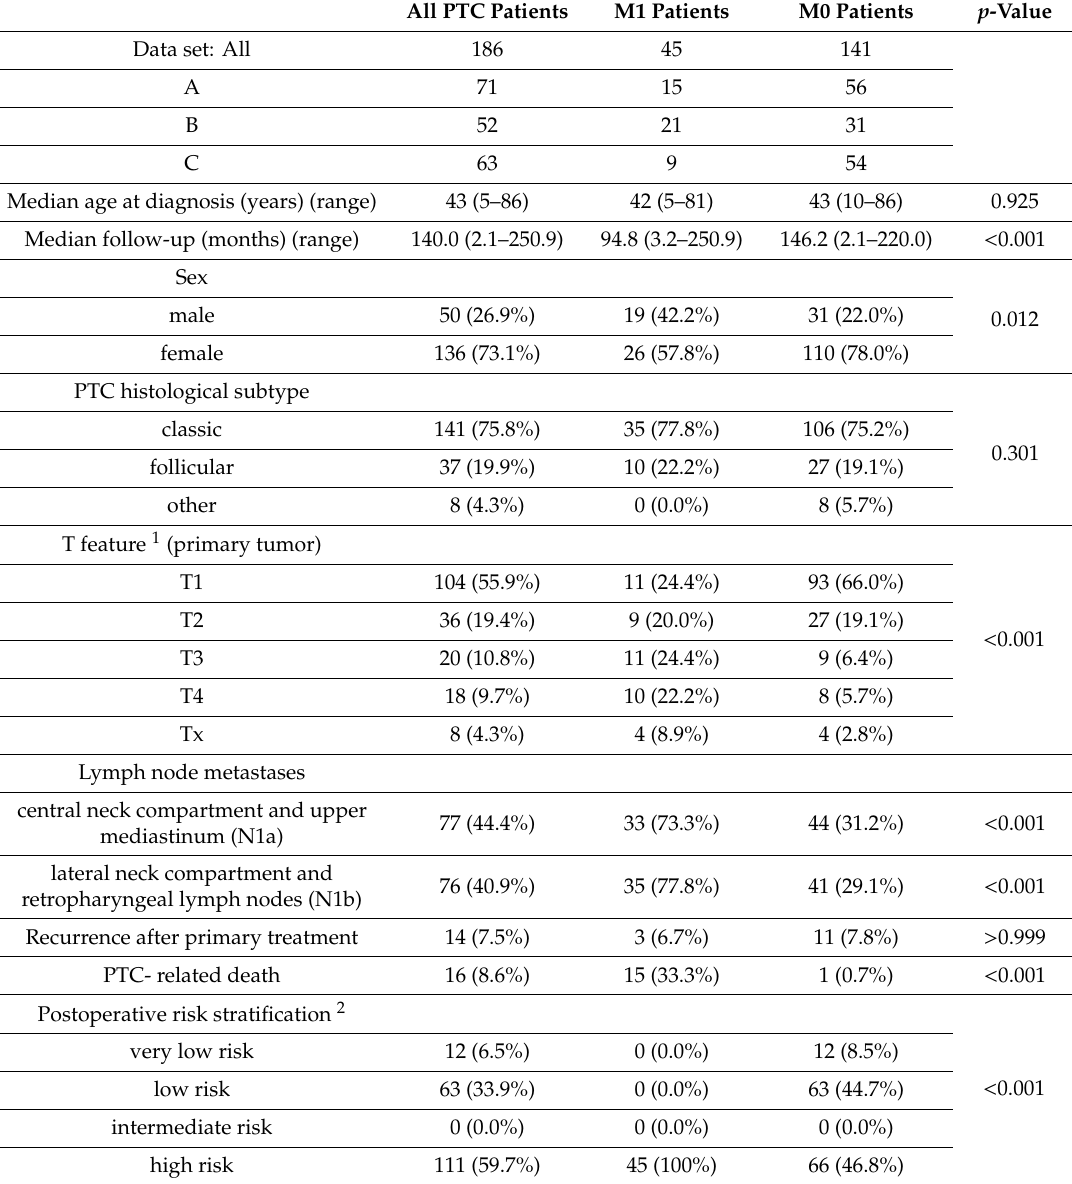
Table 4. Clinical characteristic of the whole PTC